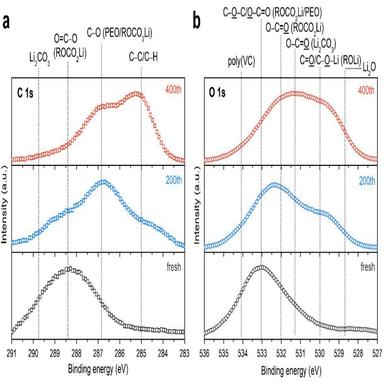
XPS spectra of the C 1s (a) and O 1s (b) for the fresh and cycled cells (200th and 400th).